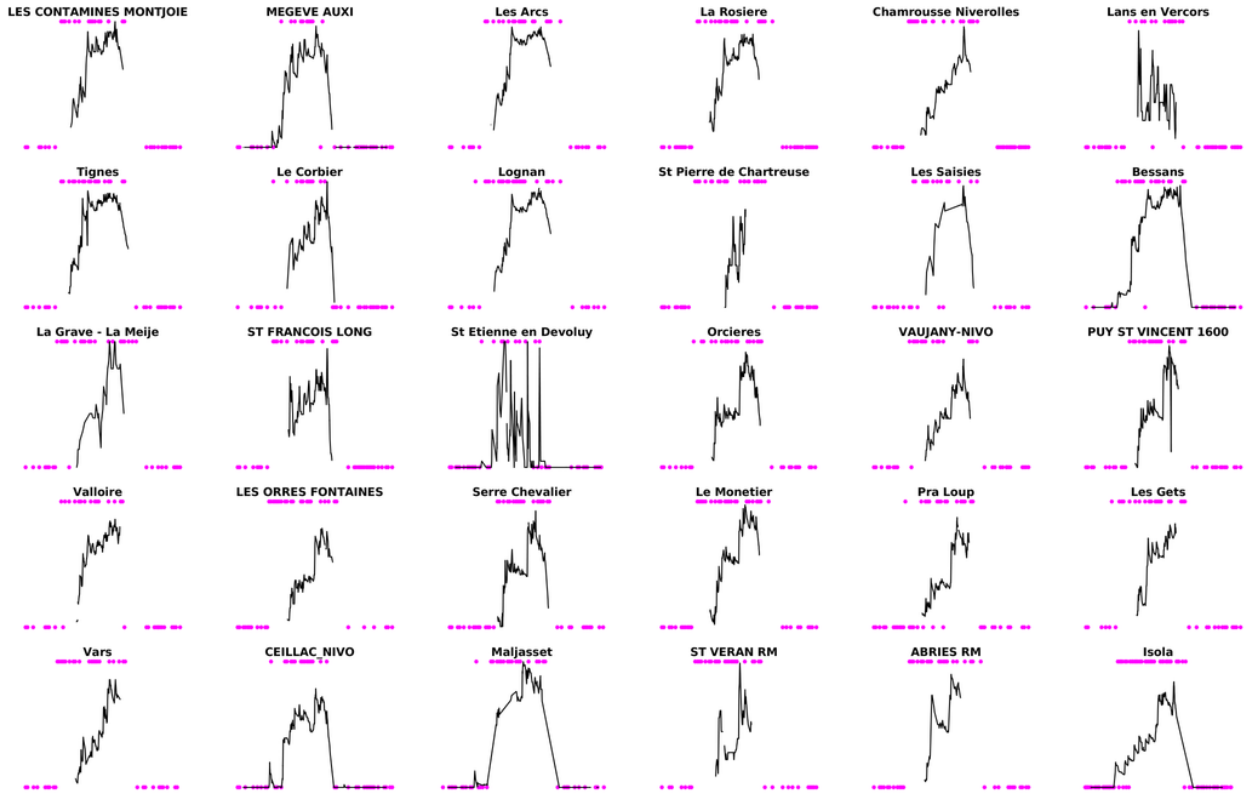
Figure B3. Magenta dots: snow presence (a) or absence (b) in the Theia snow collection. Black line: snow depth time series.